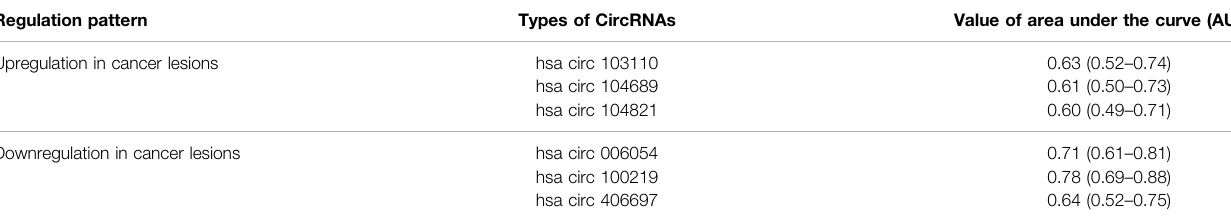
TABLE 1 | Regulation pattern of different circRNAs in cancer